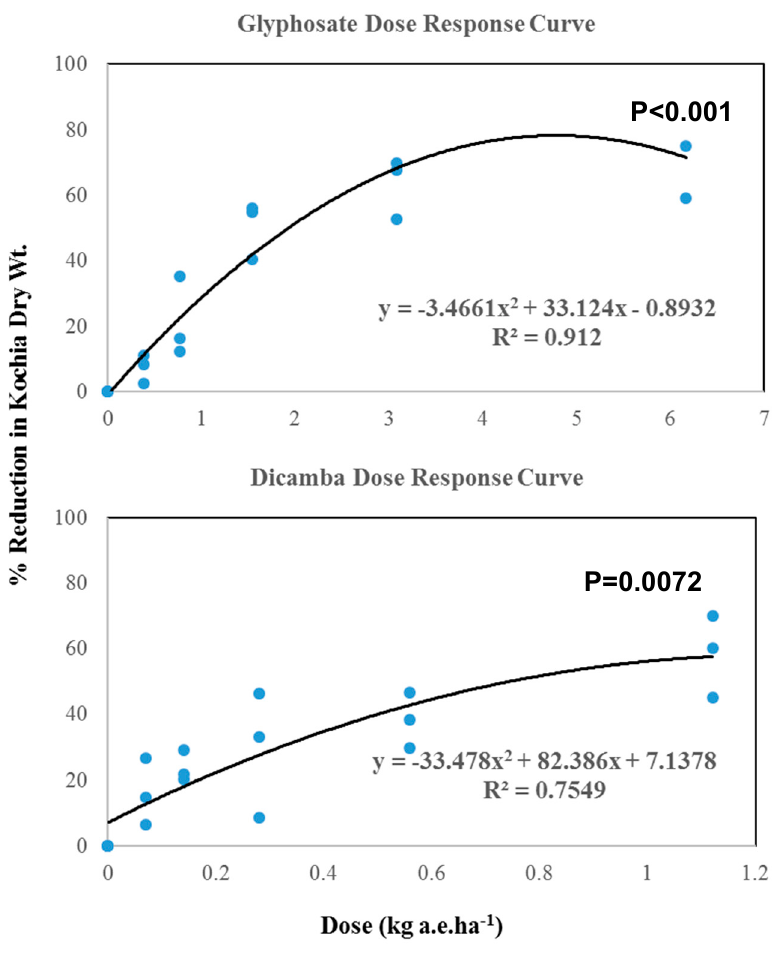
Figure 3. Regression analysis for dose-response of glyphosate and dicamba in kochia grown on PCC piles.